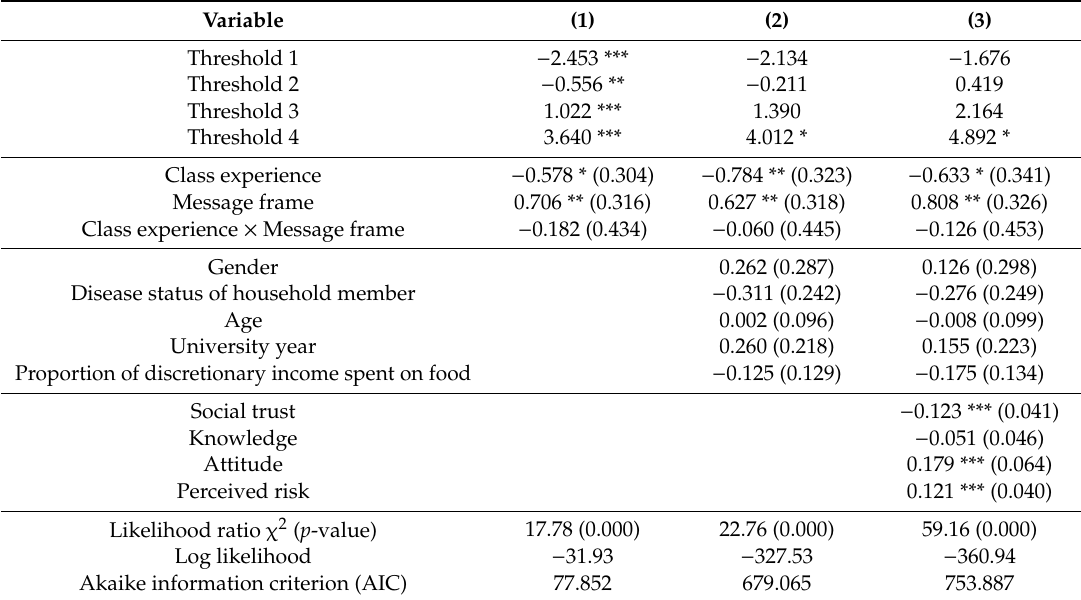
Table 6. Estimation results of ordered logistic